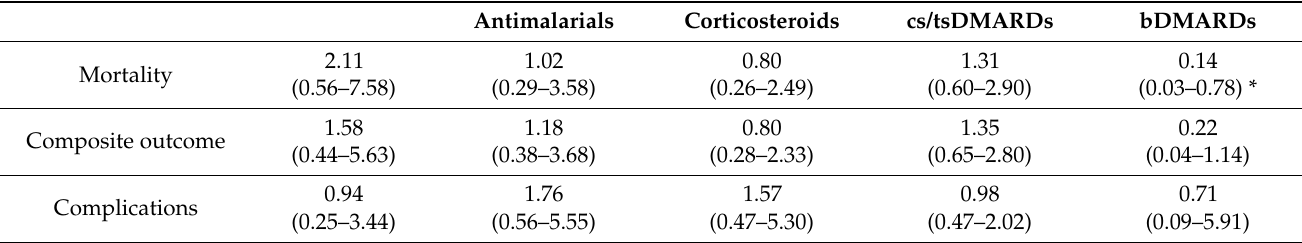
Table 6. Measures of the effect, OR (95% CI) *, of ADs as a whole and of immunomodulatory treatments prior to hospital admission with their propensity scores on the outcome variables α